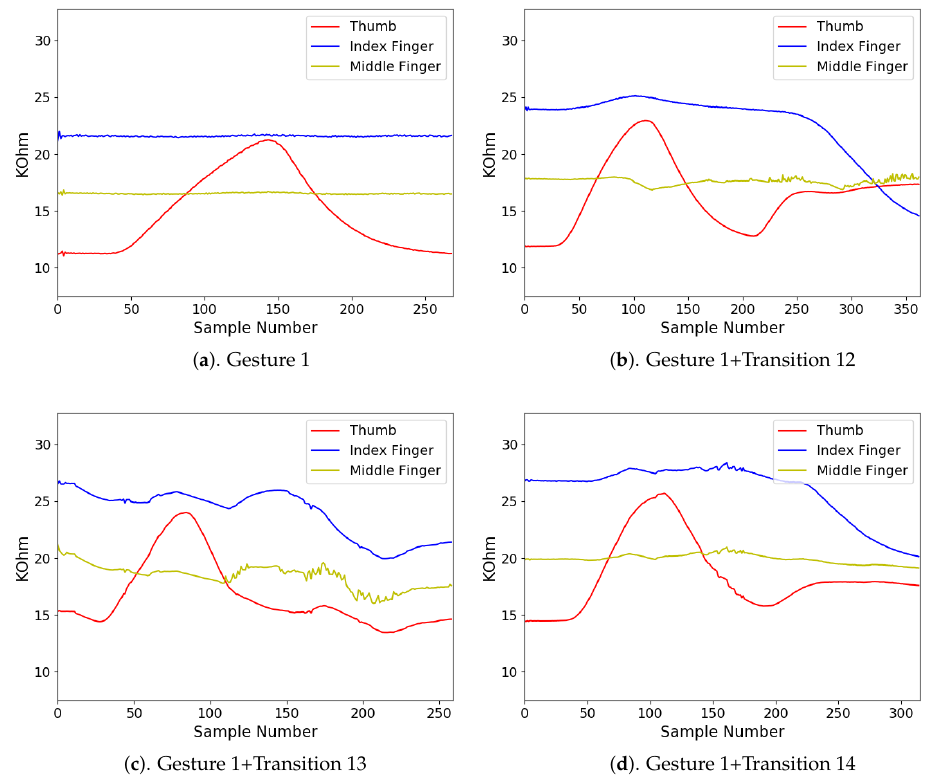
Figure 14. The measured sensory data produced by flex sensors of the smart glove for gesture class